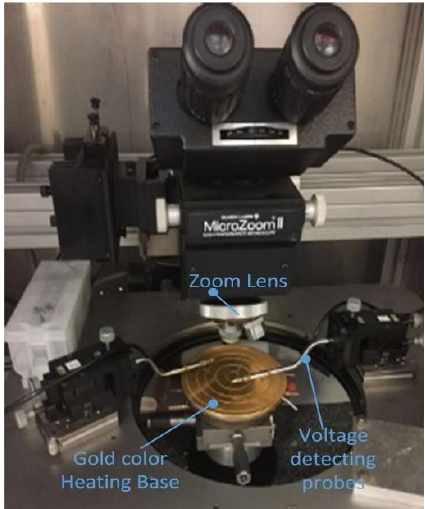
Figure 6. Experimental setup showing the thermal heating base used to detect voltage hikes of proposed thermoelectric junction design.